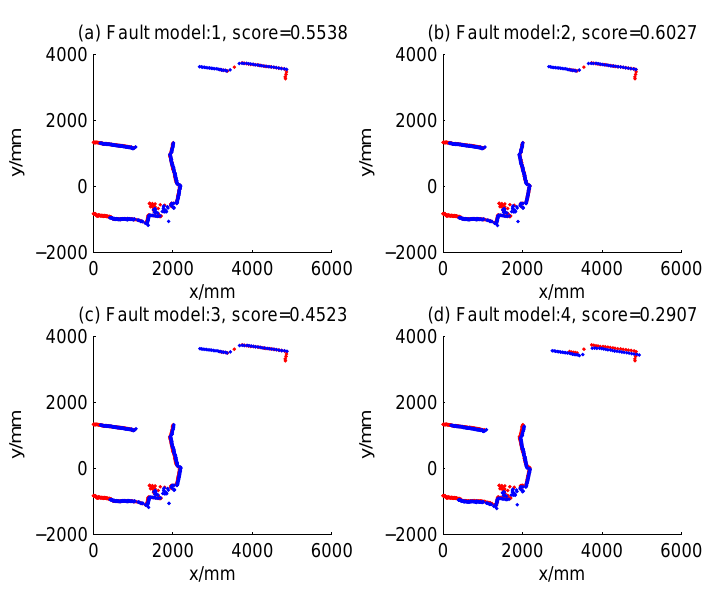
Figure 25. Diagnosability: No